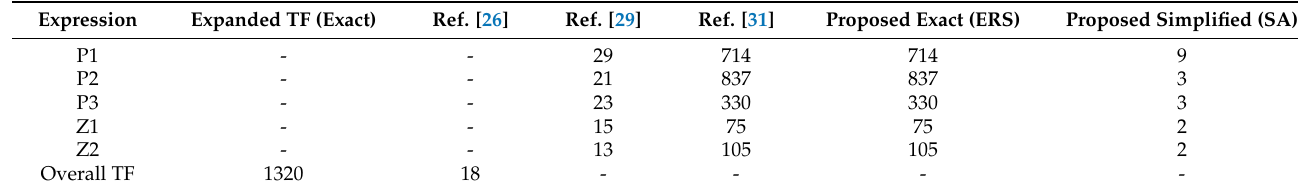
Table 8. Number of terms within the simplified symbolic poles/zeroes in Circuit 3.